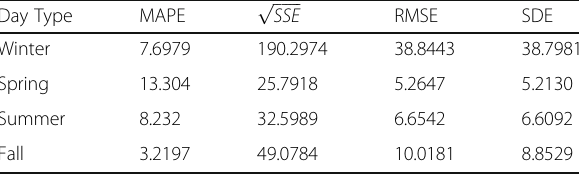
Table 1 Daily forecasting error statistical analysis